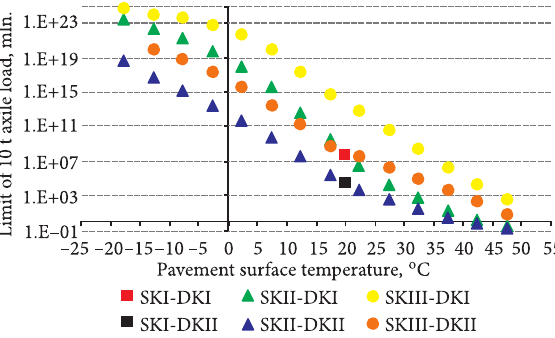
Fig. 3. The vertical stress change in pavement structures depending on distance for load centre